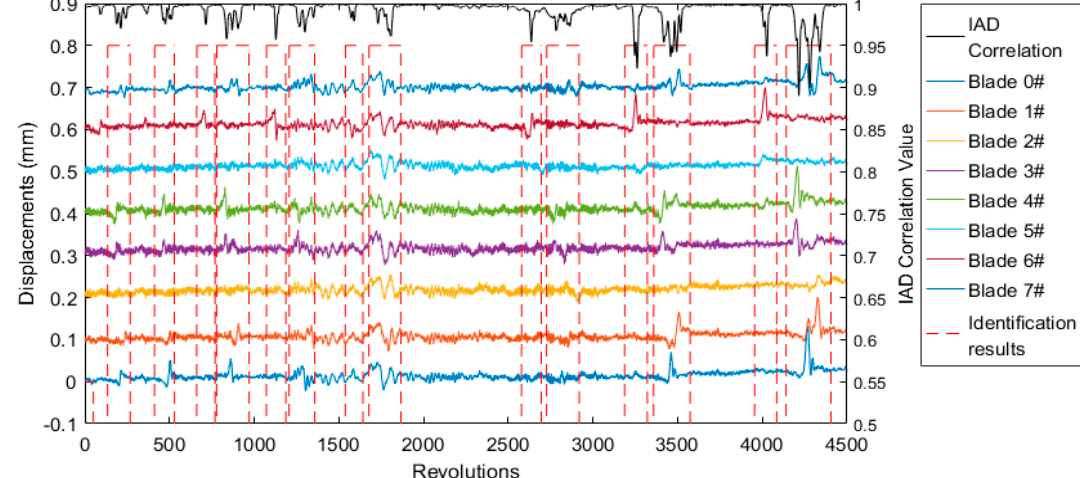
Figure 6. Identification results of blades’ overall vibration events using Equation (3).